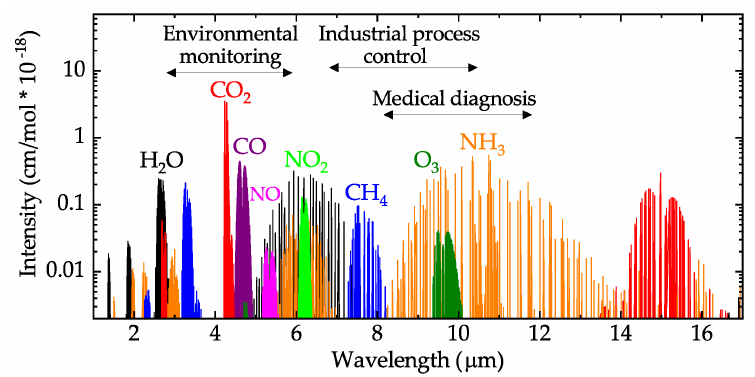
Figure 10. Mid-infrared absorption spectra of some gases